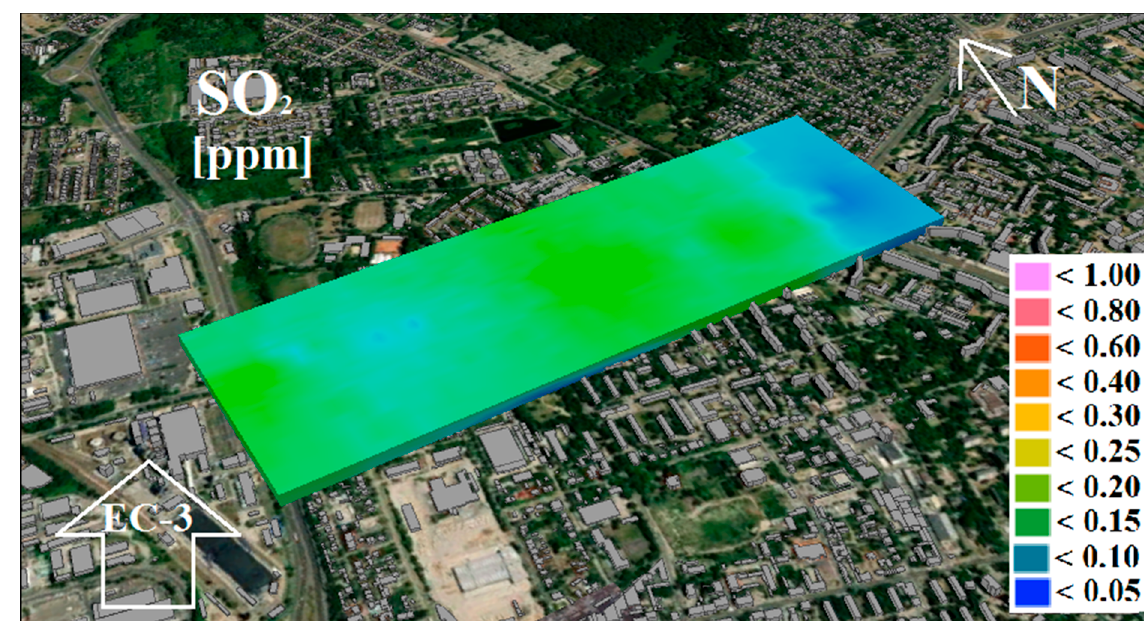
Figure 13. Spatial distribution of PM 10 concentration for a selected location in the vicinity of EC-3.